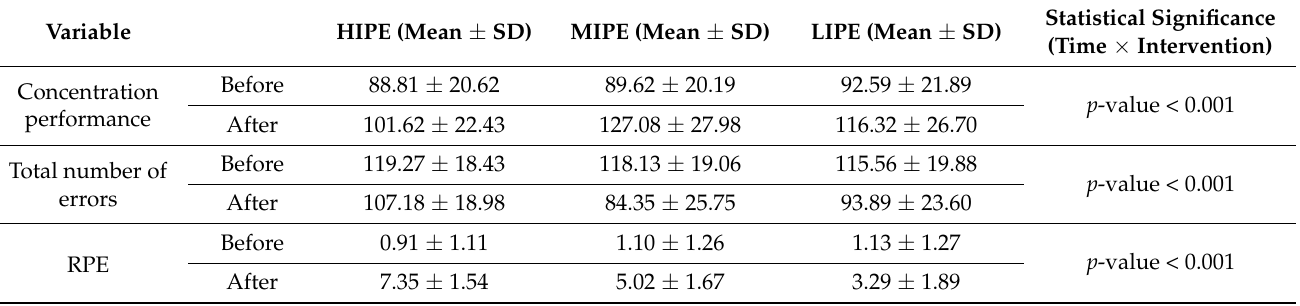
Table 1. Values of concentration performance, total number of errors, and RPE broken down according to the